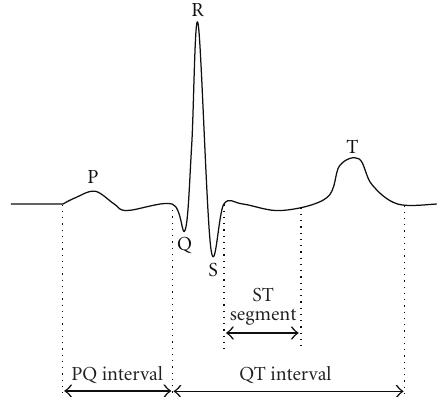
Figure 2: Illustration of the key ECG features.